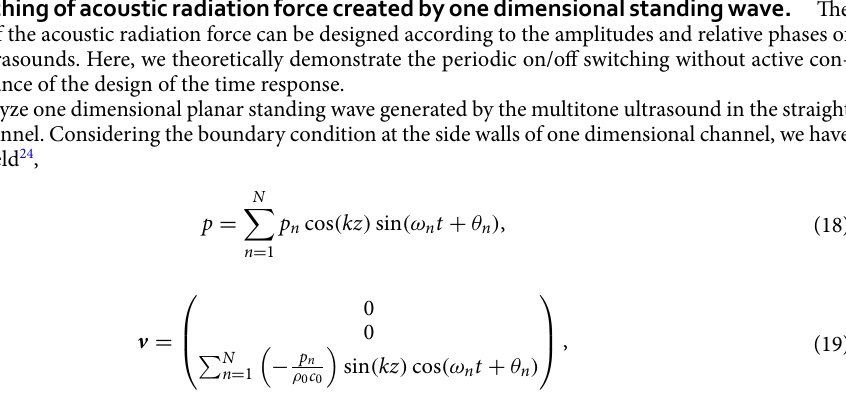
= · · · = θ = 0 and θ = π 1 5 6